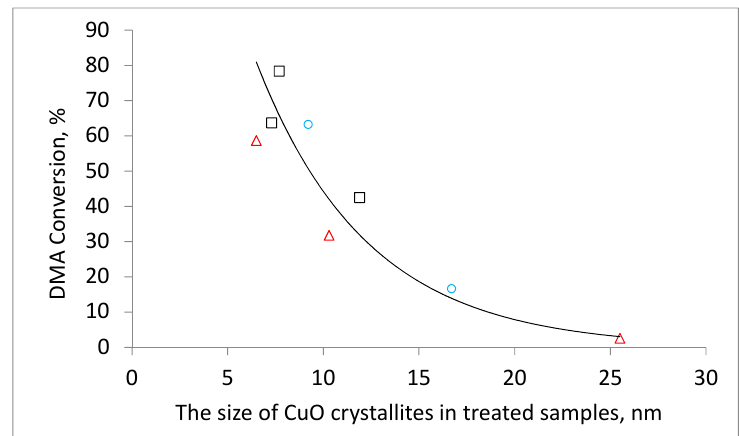
Figure 6. A correlation between the DMA conversion (after 120 min. of the reaction) and the size of CuO crystallites in the prepared CuZn catalysts. □ : calcined in air, ∆ : calcined in nitrogen, ○ : calcined in hydrogen.